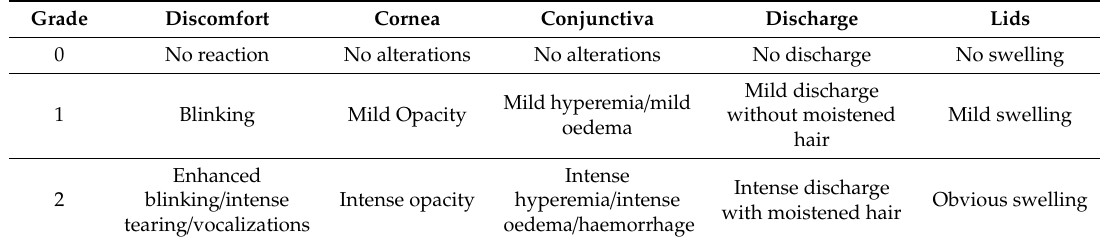
Table 1. Grading system for in vivo tolerance evaluation